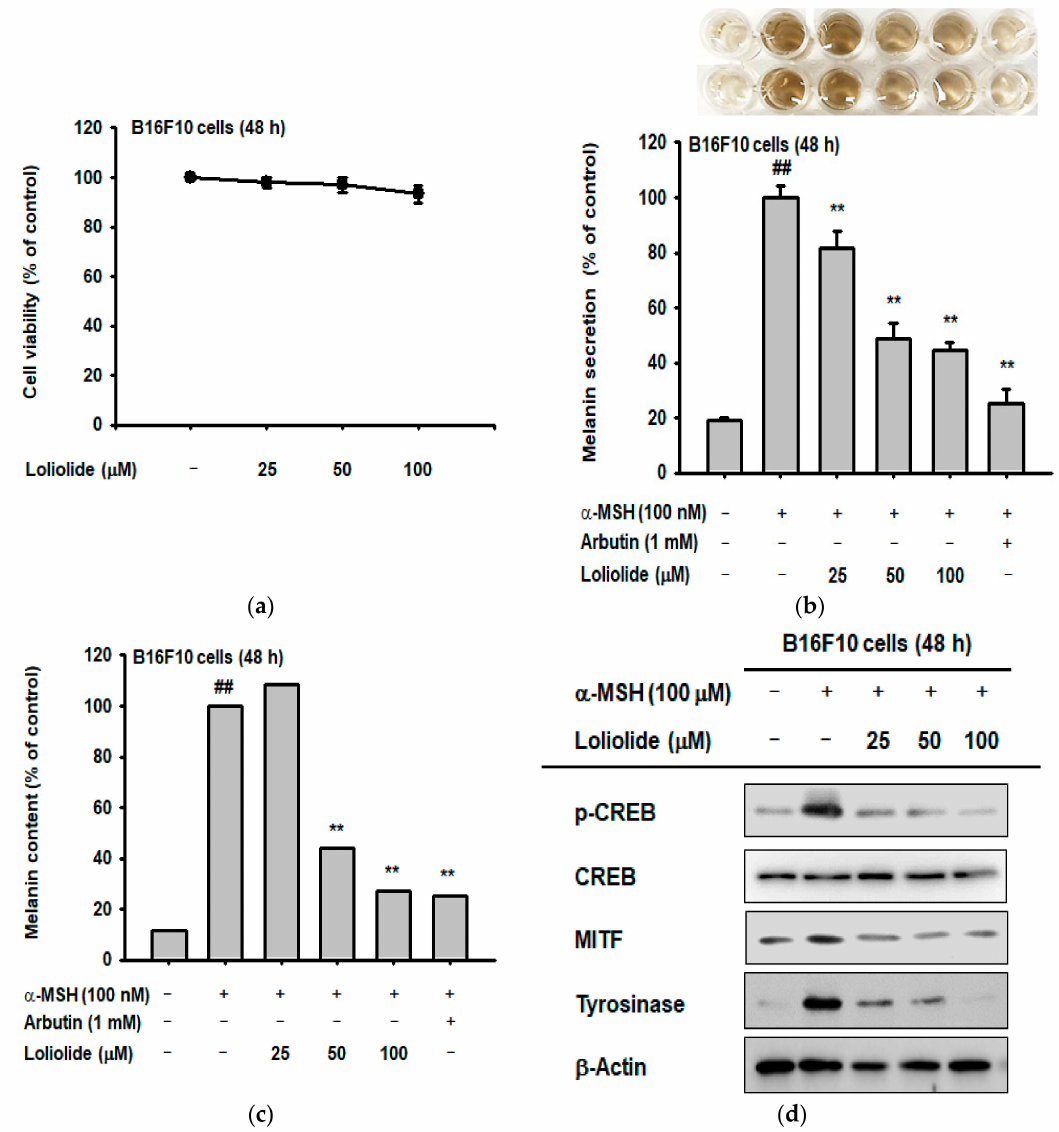
Figure 3. Anti-melanogenic effect of loliolide. ( a ) Measurement of cell viability by MTT assay in loliolide-treated B16F10 cells. ( b ) Measurement of melanin secretion by melanin secretion assay in B16F10 cells treated with α -MSH and loliolide. ( c ) Measurement of melanin production by melanin content assay in B16F10 cells after treatment with α -MSH and loliolide. ( d ) Western blot analysis of the expression of MC1R signaling pathway proteins in α -MSH- and/or loliolide-treated B16F10 cells. Statistical significance ( b , c ) was evaluated using the Kruskal–Wallis/Mann–Whitney test. ## p < 0.05 compared with normal group and ** p < 0.01 compared with